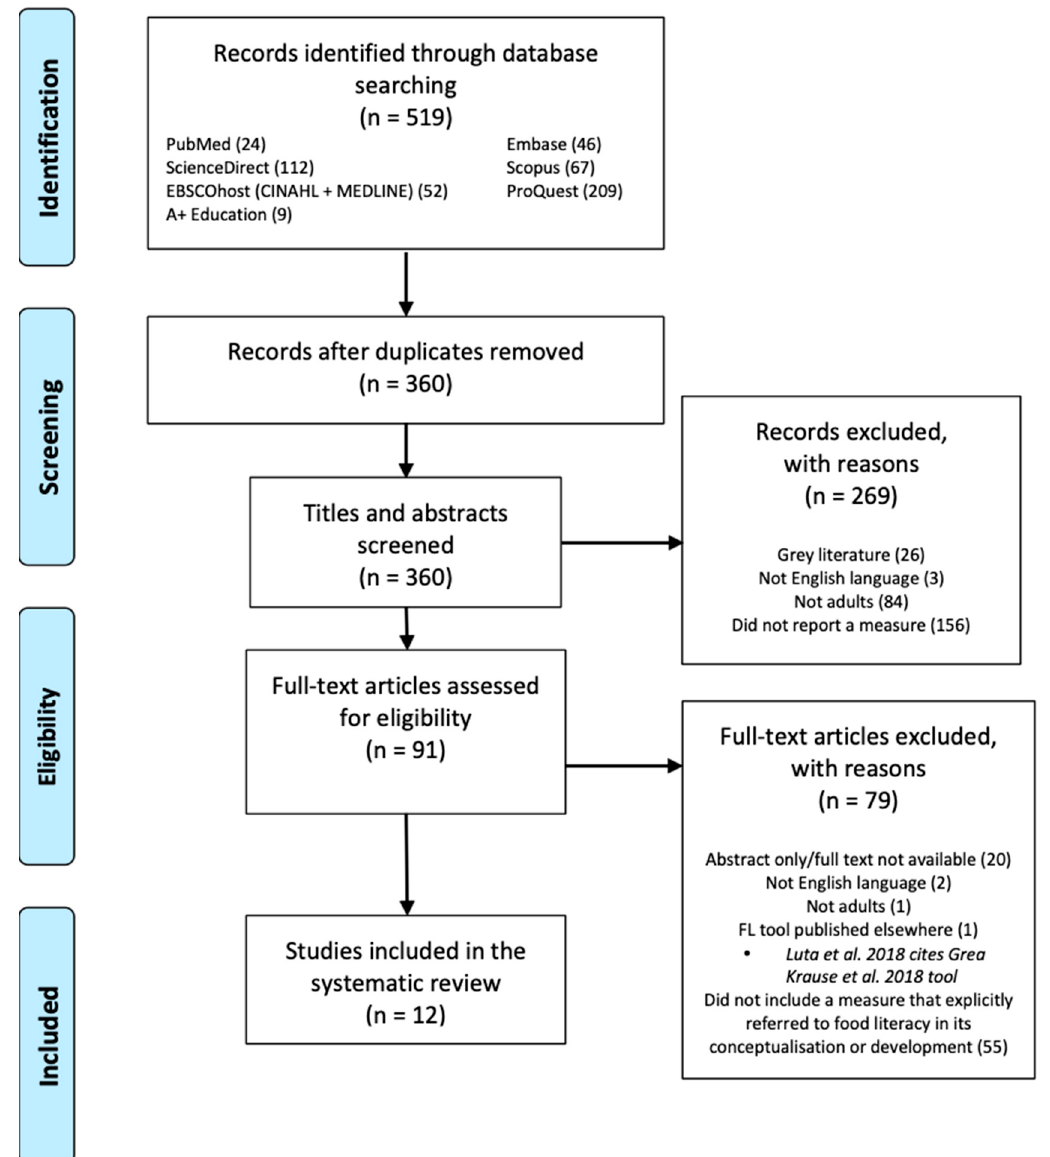
F igure 1. PRISMA flow chart Figure 1. PRISMA flow